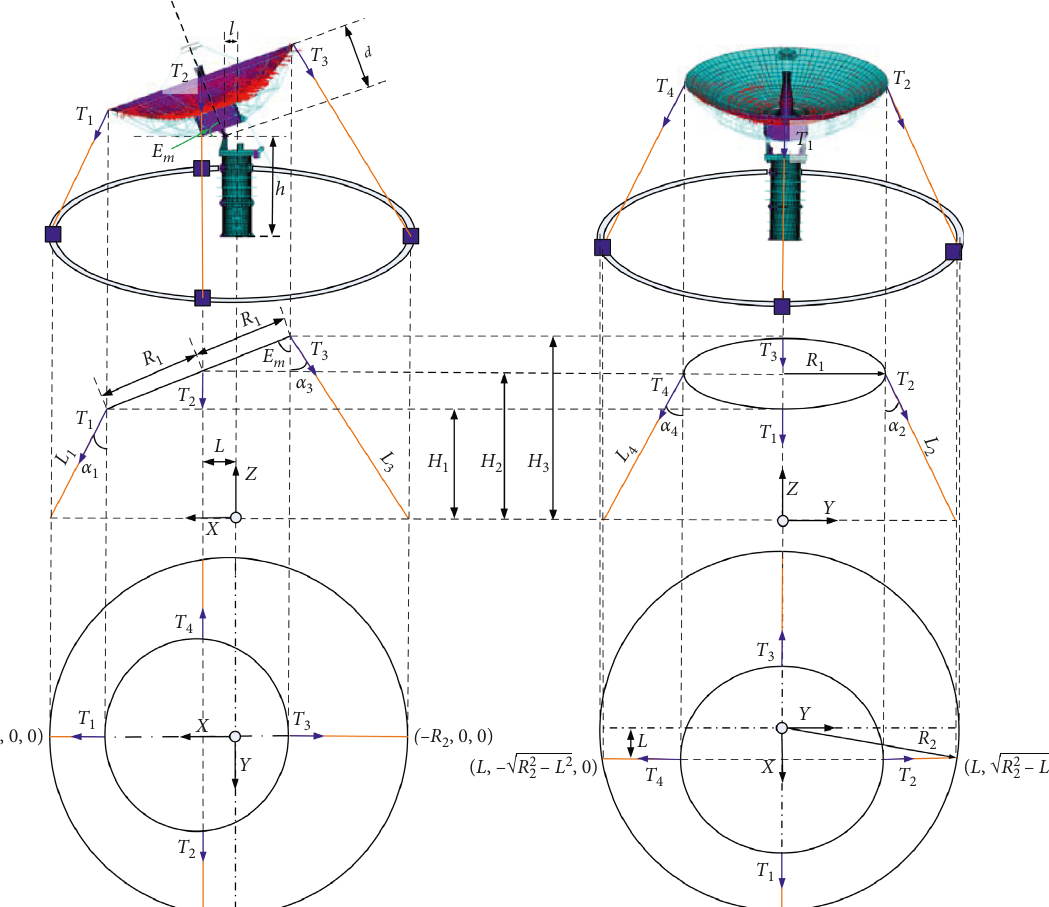
Figure 2: Geometric relations of various elements.